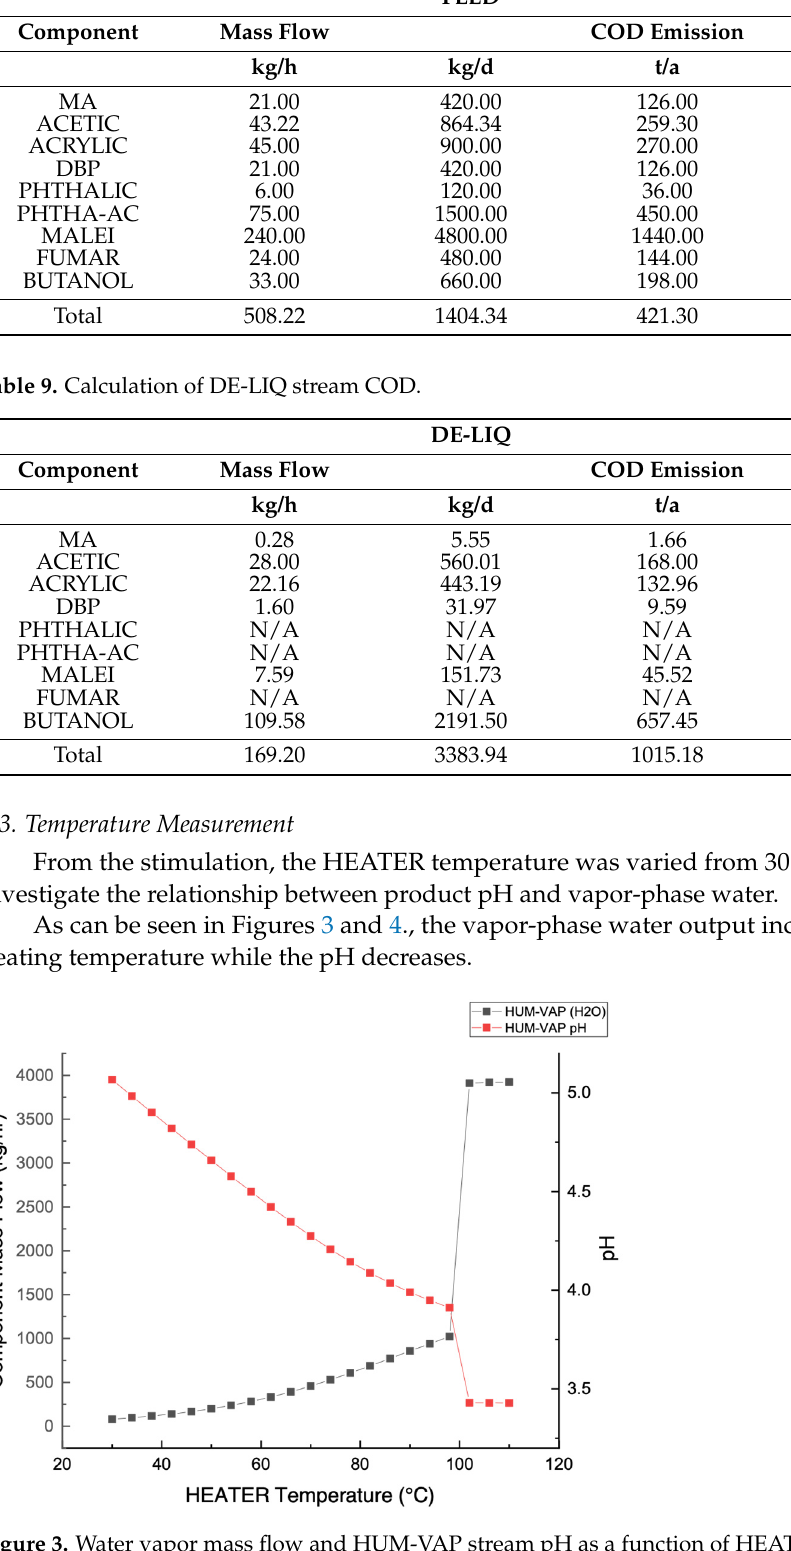
Figure 3. Water vapor mass flow and HUM-VAP stream pH as a function of HEATER tempera- ture.